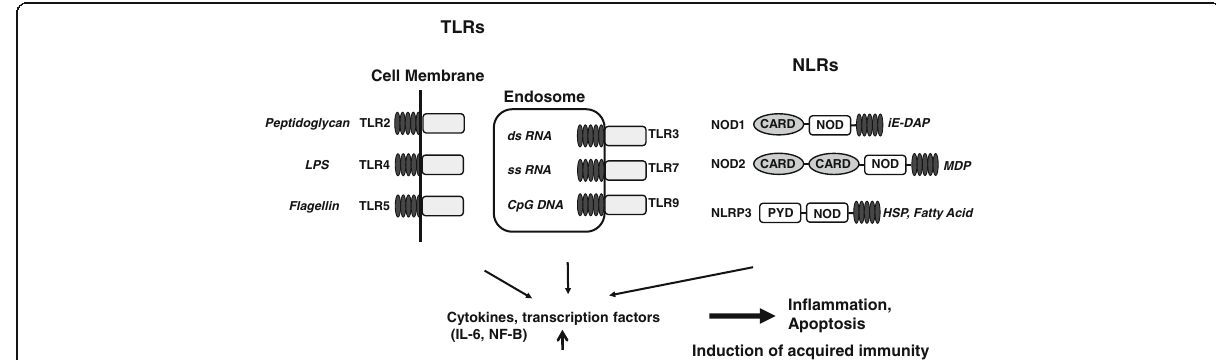
Fig. 1 Innate immune receptors, NLRs and TLRs. The main members of the innate immune system are NLRs (membrane binding) and TLRs (in the cytosol). NLRs and TLRs sense intracellular and extracellular PAMPs, respectively. The subsequent activation of inflammatory cytokines including IL-6 and NF- κ B results in the inflammation, apoptosis, and autophagy. These pathways are involved in the induction of